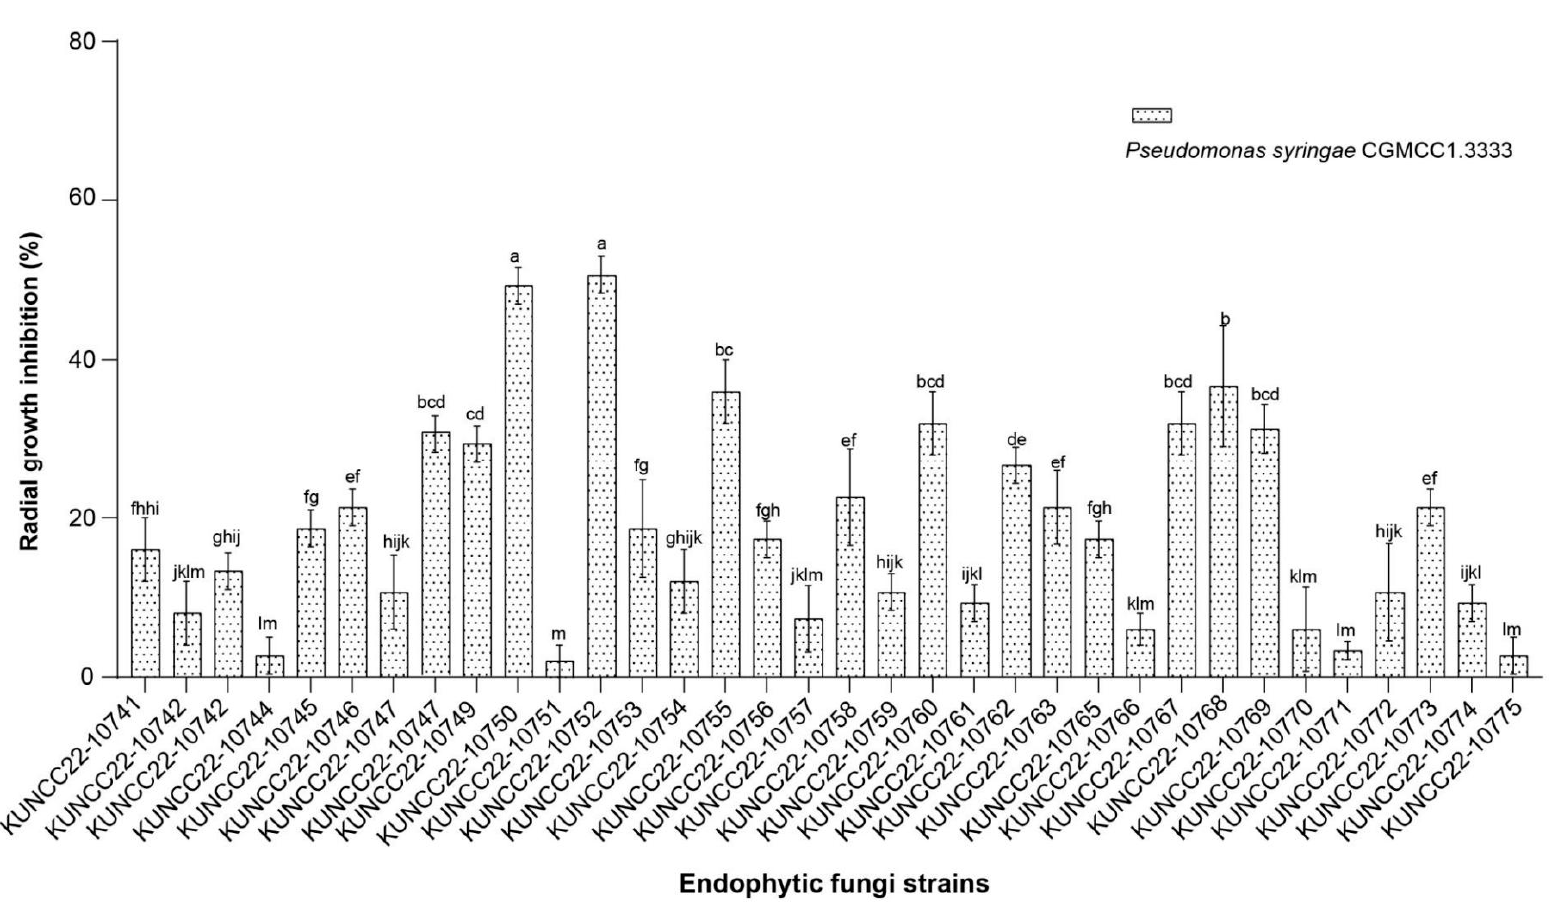
Figure 7. Inhibition rates of different fungal endophytes to bacterial pathogen Pseudomonas syringae (GCMCC1.3333). The bars denoted by the same letter are not significantly different from each other.